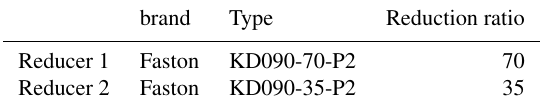
Table 2. Parameter of the